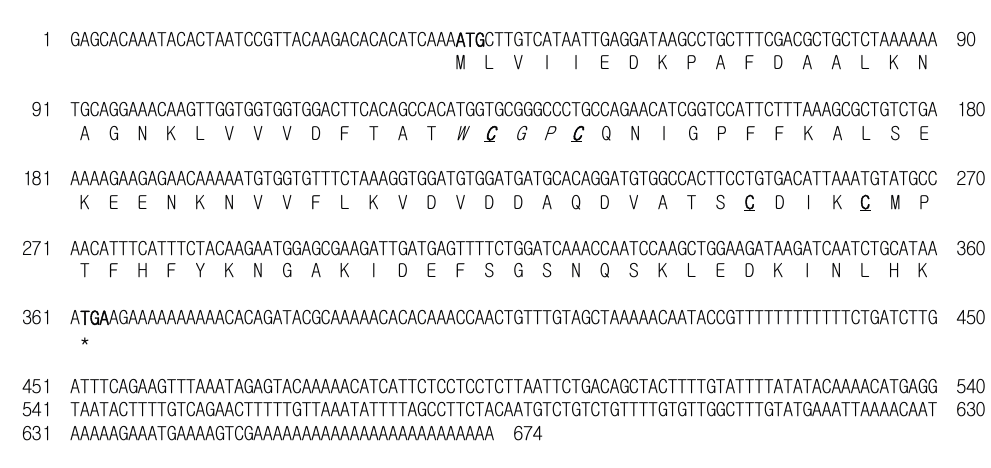
Figure 1. Nucleotide and deduced amino acid sequences of the R. uyekii thioredoxin (RuTrx). The start codon and stop codon are shown in bold. The active cysteine and two other cysteine residues are in bold and underlined, and the active site WCGPC is